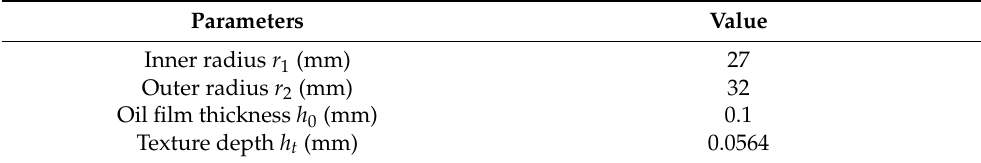
Figure 6. Schematic diagram of oil film with cylindrical texture. Table 1. Structure parameters of friction pairs.